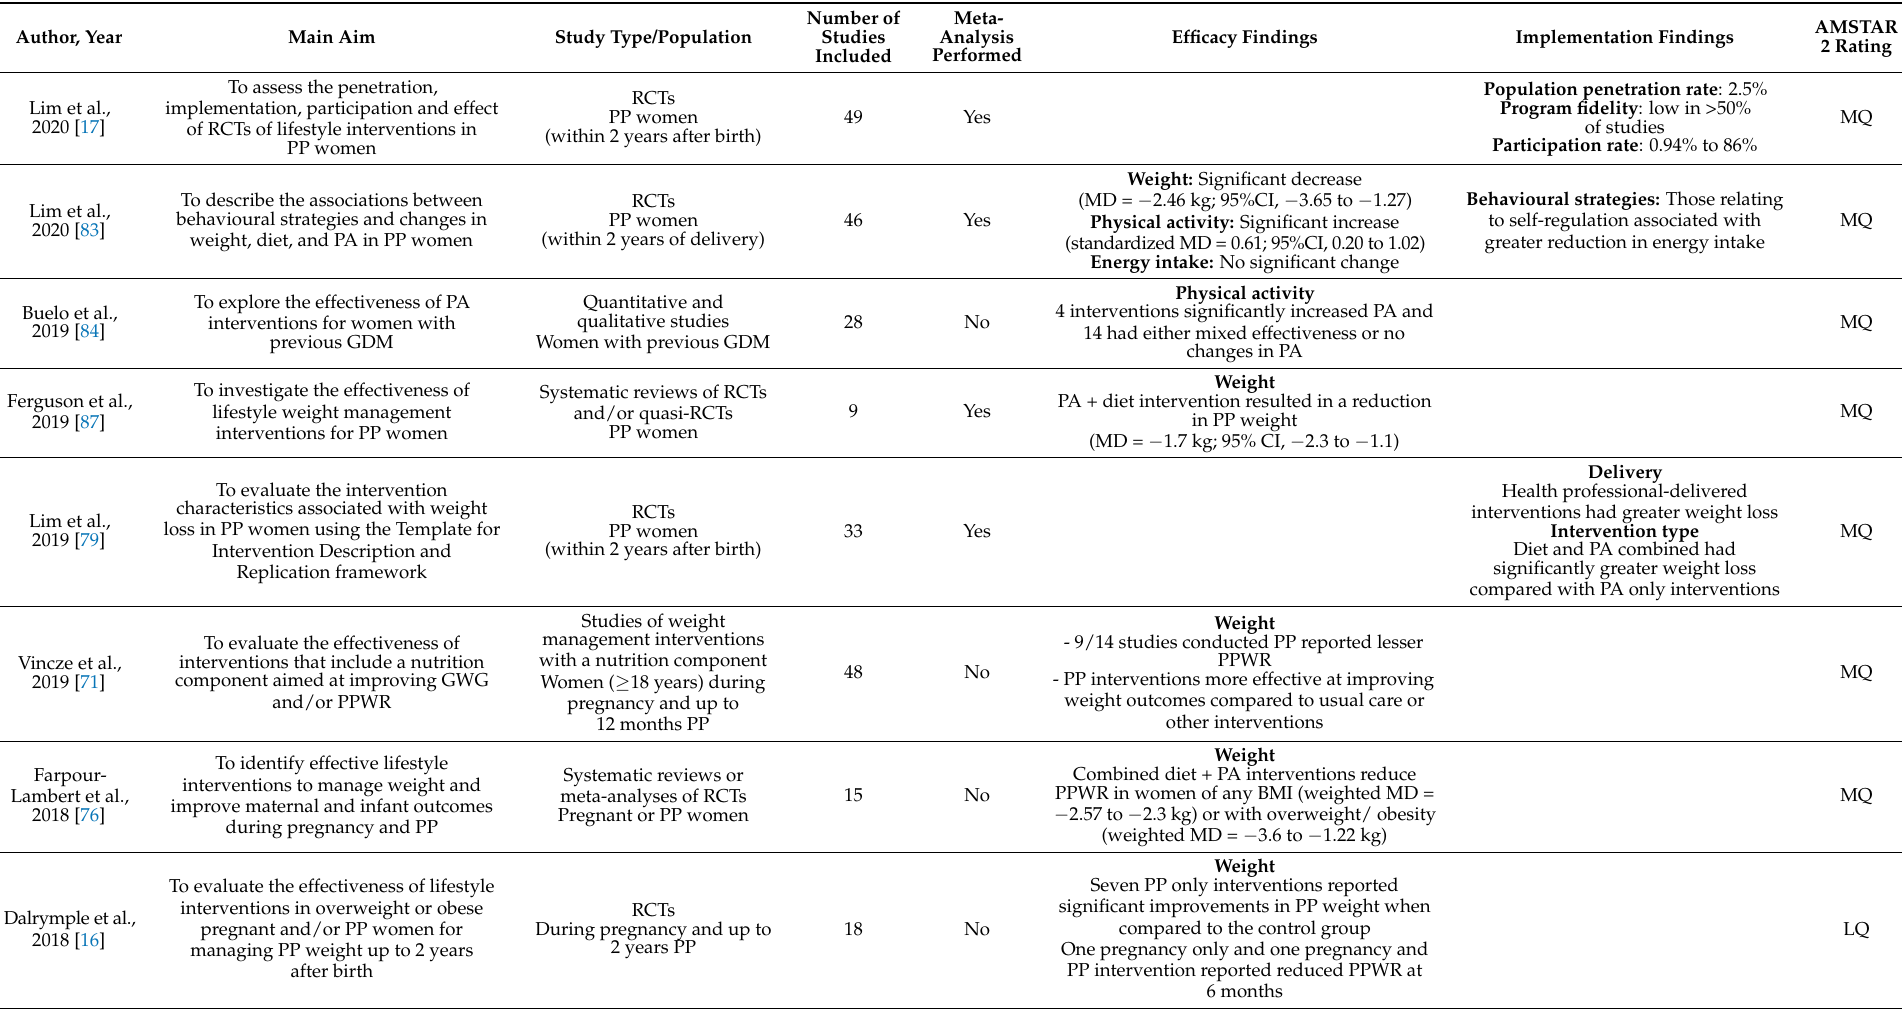
Table 2. Summary of systematic reviews examining the efficacy of lifestyle interventions in postpartum